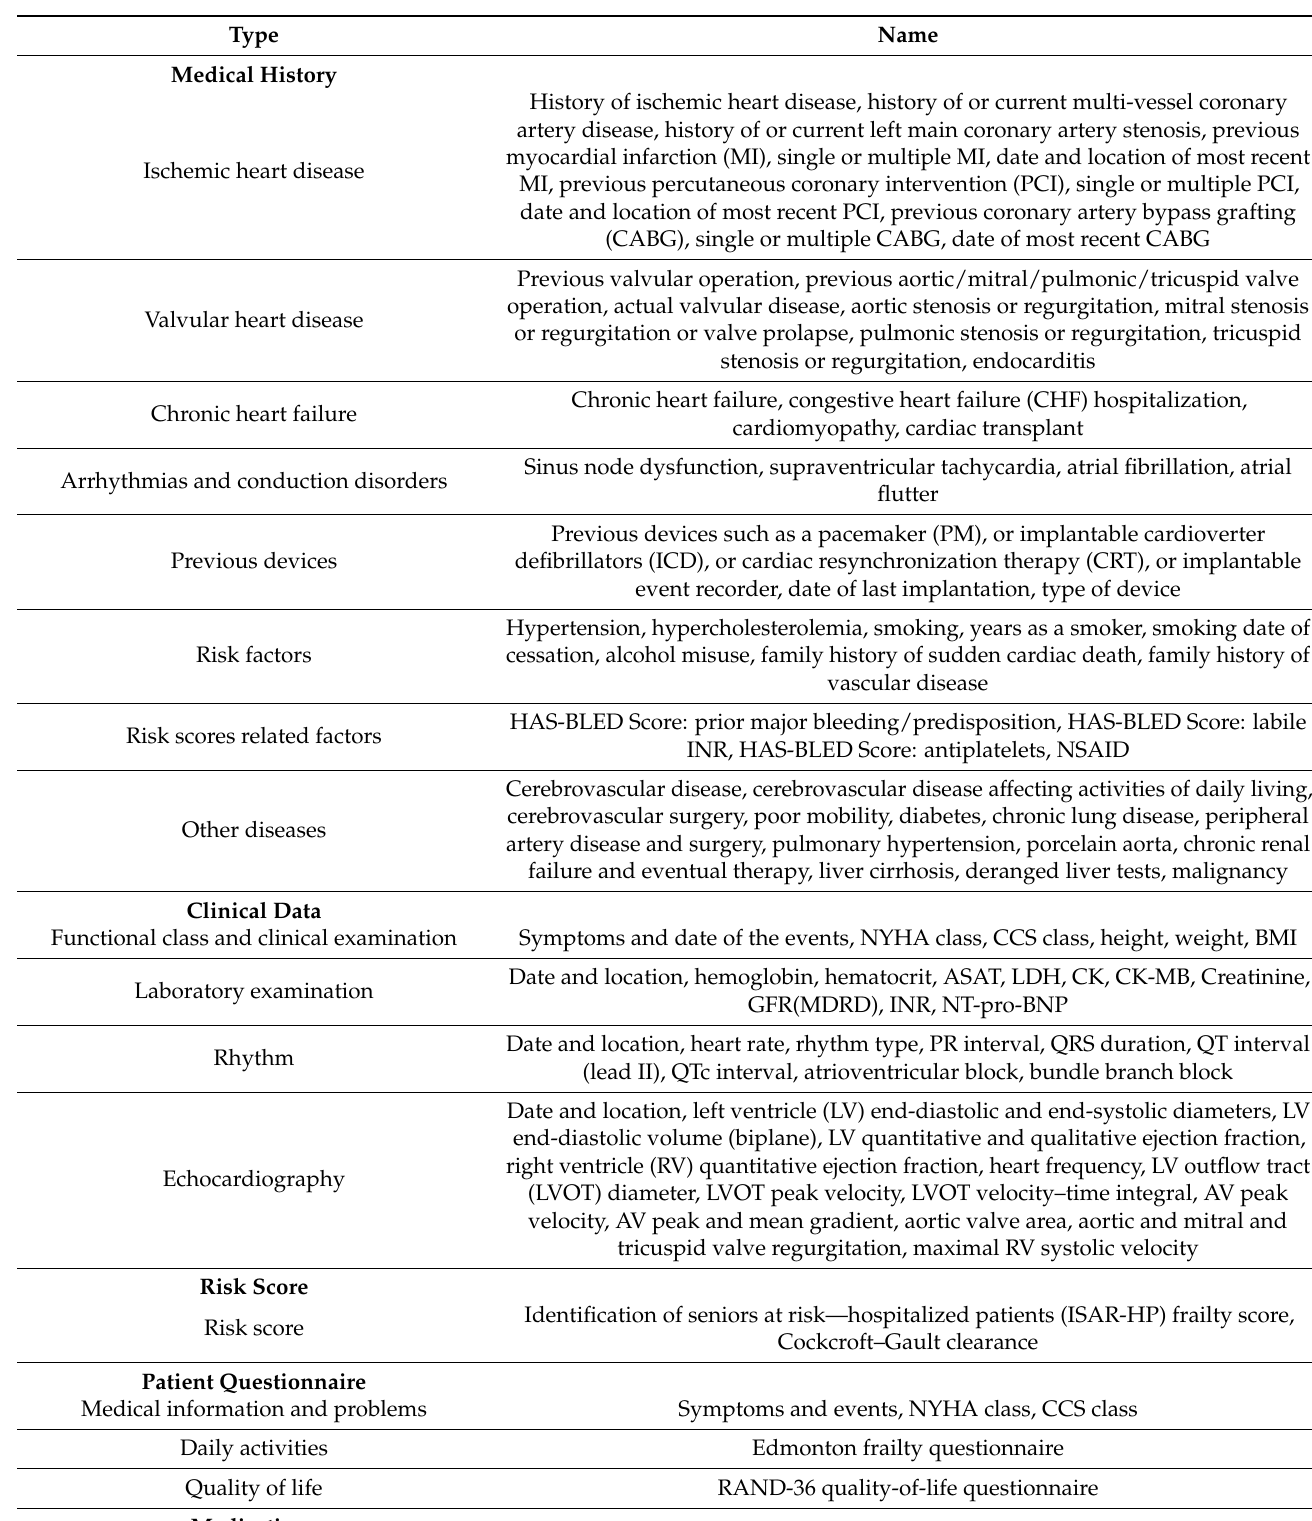
Table 1. Complete dataset